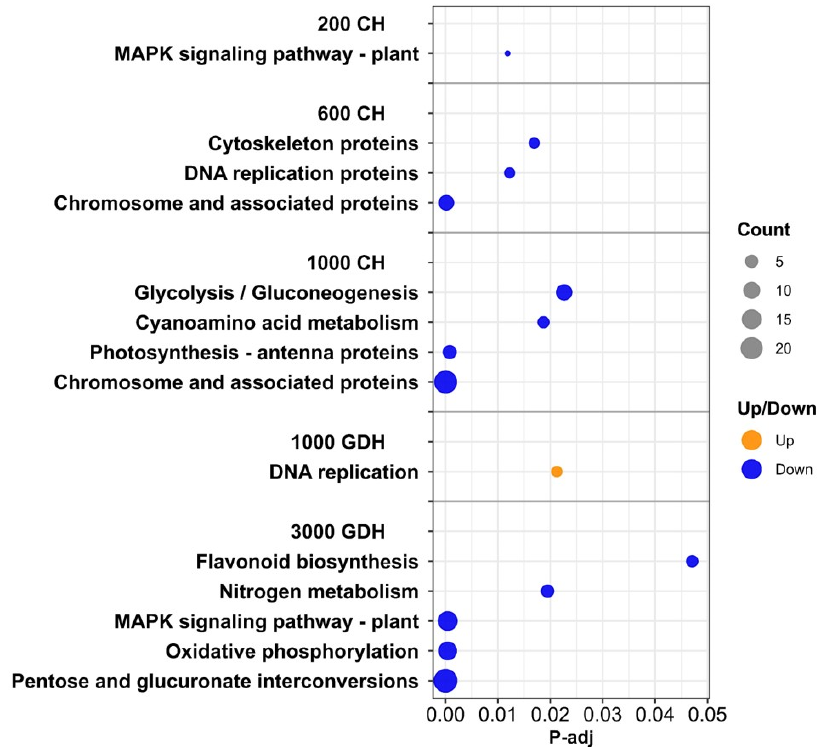
Figure 7. Significantly enriched KEGG pathways of the DEGs between the ET treatment and the control from five time points during endodormancy and ecodormancy. Dot size represents the number of genes enriched in each KEGG pathway. Orange dots represent up-regulated DEGs, and blue dots represent downregulated DEGs, respectively.